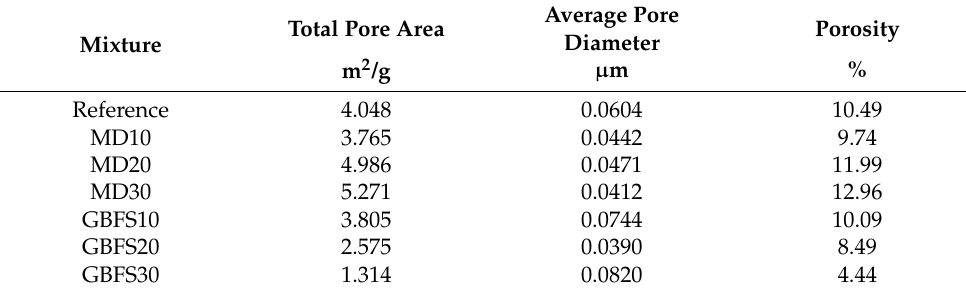
Table 6. Mercury intrusion porosimeter results of the SCC